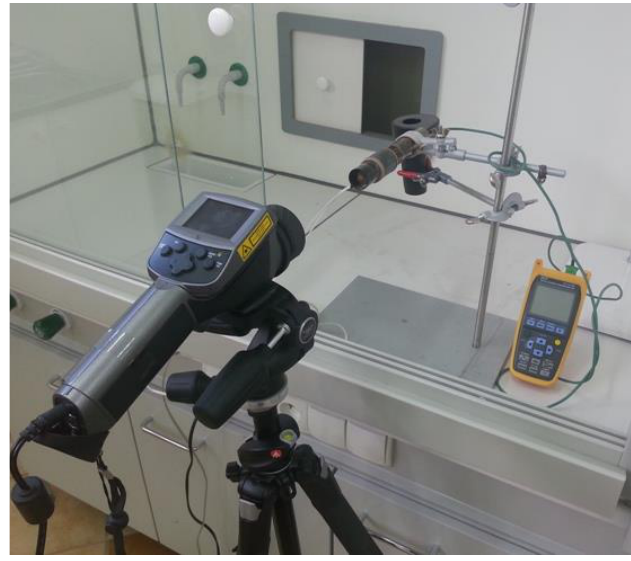
Figure 3. Thermal imaging camera FLIR ThermaCAM E300.